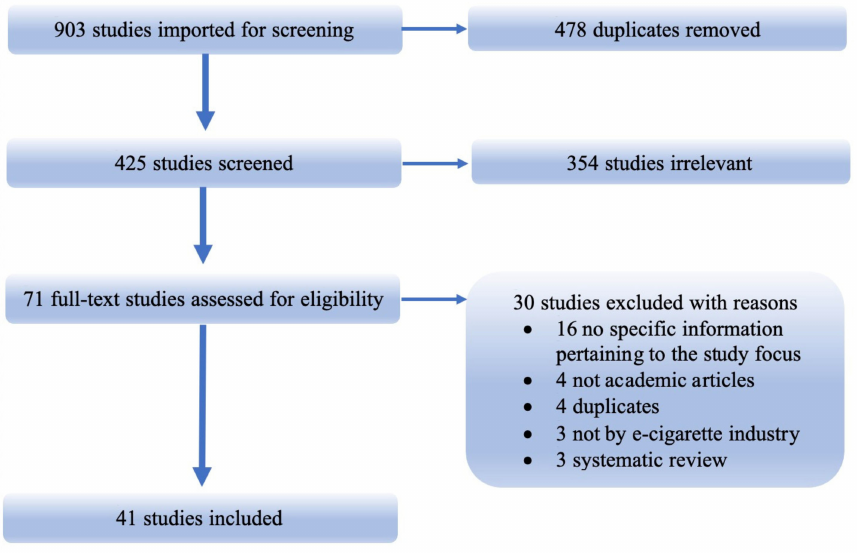
Figure 2. PRISMA diagram for study